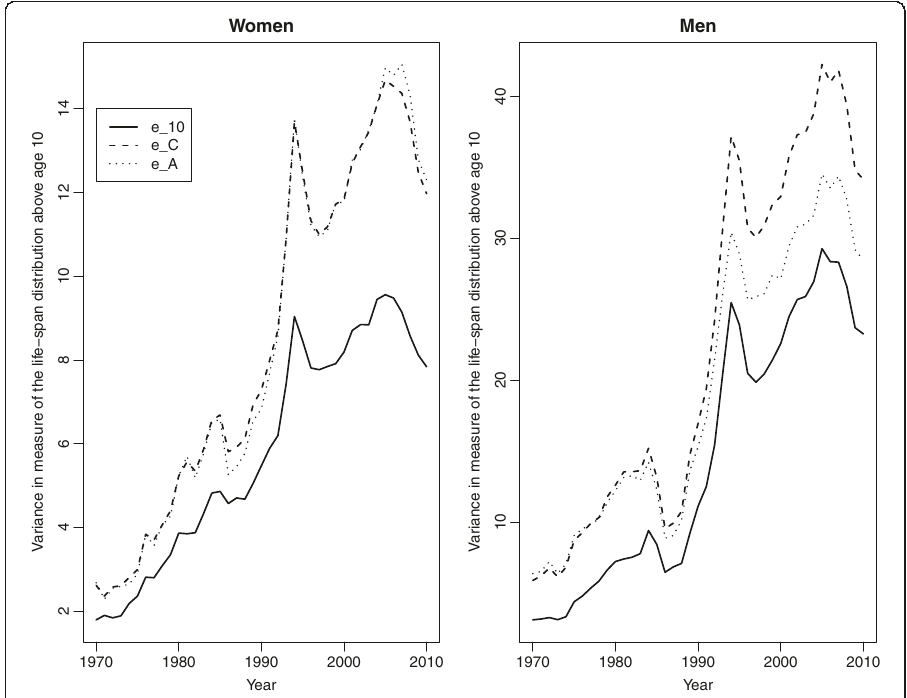
Fig. 1 Variance in mortality between the 35 developed countries, according to three summary measures of the age-at-death distribution, 1970 – 2010. Notes: the figure shows variance in statistics of the distribution of life-table ages at death above age 10; e 10 is the life expectancy at age ten; e C is the Equivalent Length of Life with e 10 adjusted for dispersion of ages at death above age 10; e A is the Equivalent Length of Life with e 10 adjusted for dispersion and skewness of ages at death above age 10. Source: Authors ’ estimations based on Human Mortality Database and lower negative skewness of the distributions (Appendix: Table 3 and Fig. 2). The low mean and relatively high variance of ages at death in Eastern Europe have been discussed in detail by D ’ Albis et al. (2014). The lower negative skewness we observed for Eastern European countries results mainly from a lower variability, or compression, of ages at death among the longest-lived 50 % of individuals than in the remaining countries.